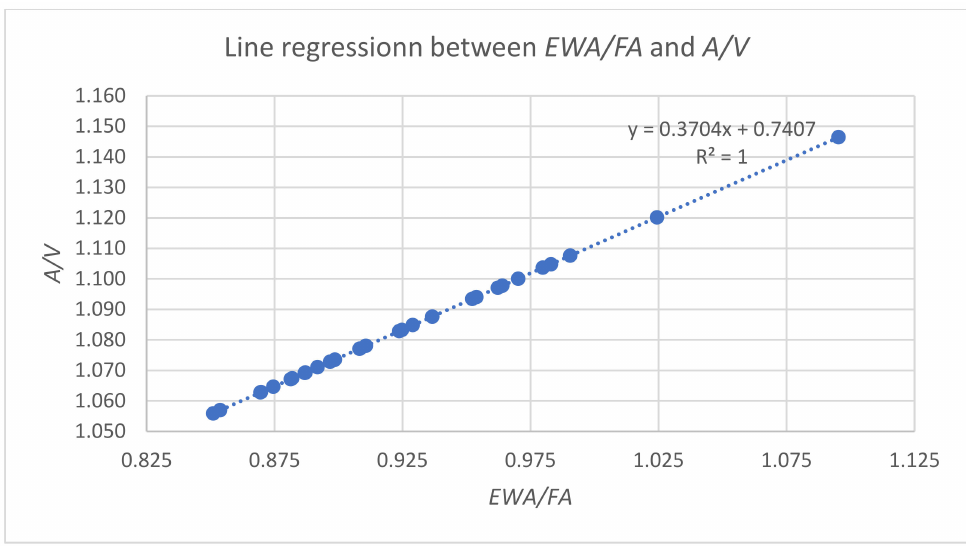
Figure 4. Perfect fit of the regression line for EWA / FA and A / V parameters as an illustration of their mutual linear relationship